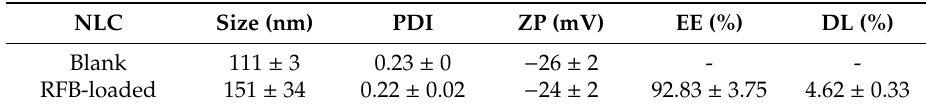
Table 1. Blank and RFB-loaded NLC characterization in terms of particle size, PDI, ZP, EE, and DL (n = 3 ±